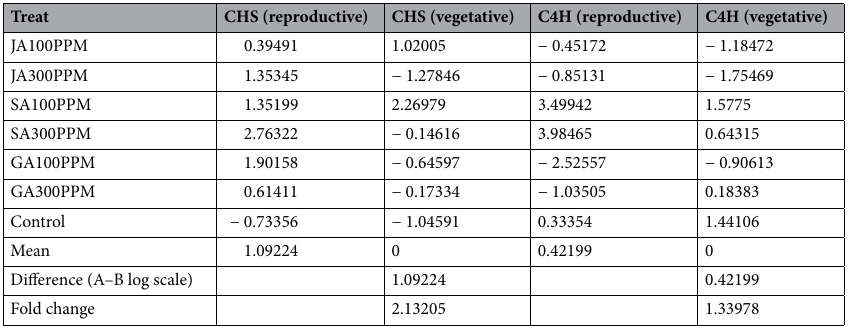
Table 2. The results of T-test in terms of estimating the ratio of changes and the significance level between the aerial samples undergone different hormonal treatments at different phenological stages. A difference in row (A–B log scale) indicates the -ddct content and row of ratio of the changes also indicates this ratio in target genes in the reproductive phase compared to the vegetative phase. Correspondingly, the ratios of the changes for CHS and C4H genes were obtained as 2.13 and 1.34, respectively.